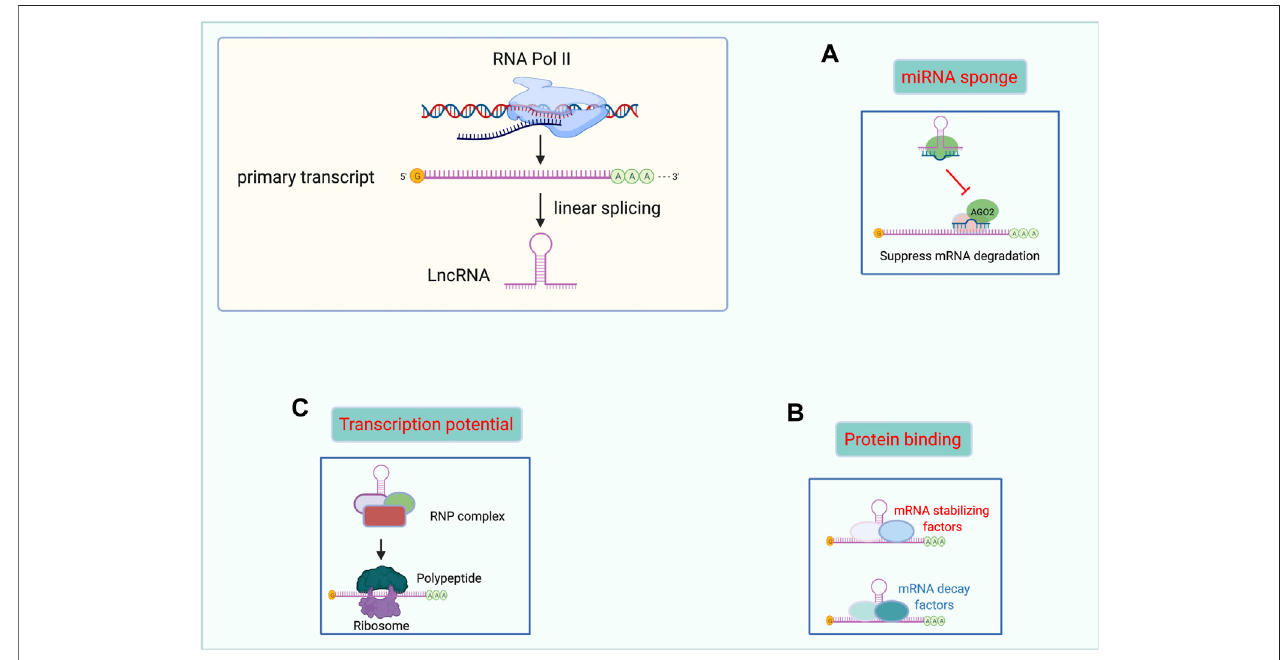
FIGURE1| FunctionalmechanismsoflncRNAs.lncRNAscanactasmiRNAssponges (A) ,bindingwithproteins (B) ,andtemplatesforpolypeptidetranslation (C) . Abbreviations: lncRNA, Long non-coding RNA. miRNAs, microRNAs. RNP complex, ribonucleoprotein